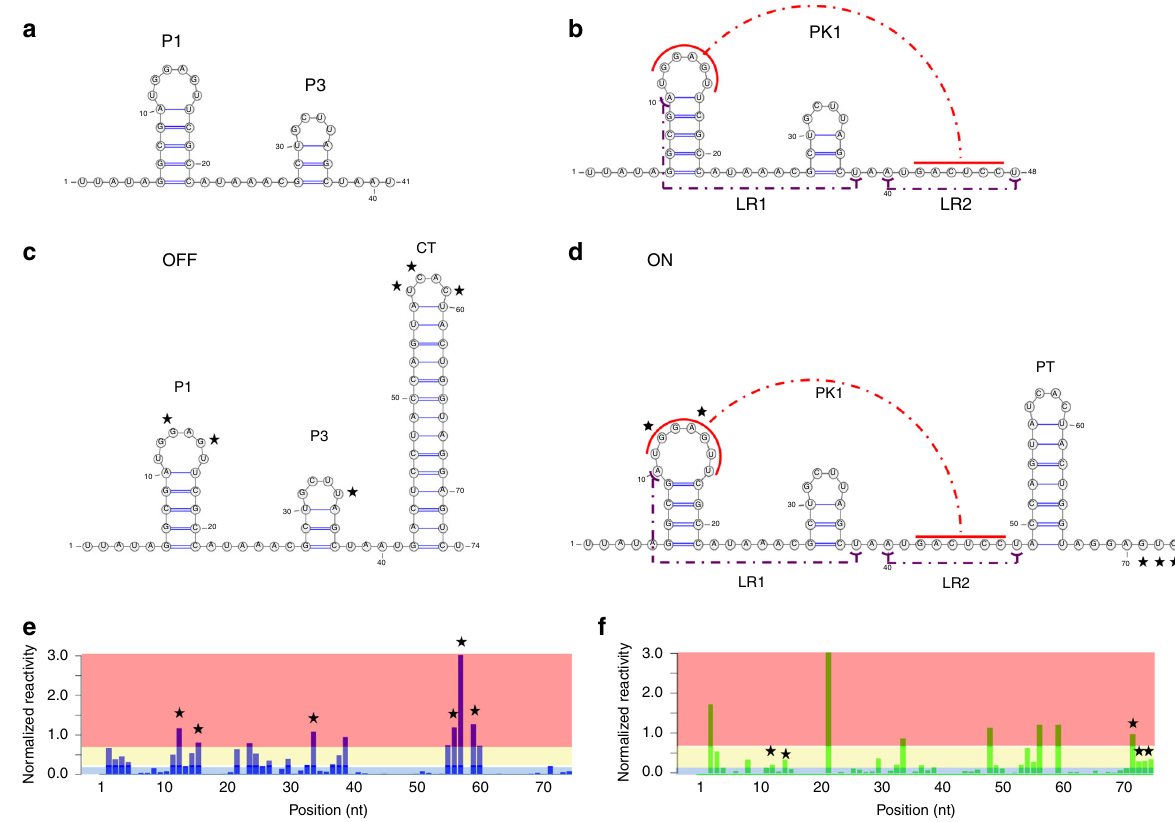
Fig. 3 Structures that govern cotranscriptional folding of crcB fl uoride riboswitch and reactivity pro fi les after formation of a complete terminator (CT). a , b Dominant motifs P1, P3, and PK1 form at intermediate transcript lengths 26, 41, and 49 nt independently of fl uoride presence. c , d At suf fi cient transcript length, fl uoride-dependent structural bifurcation takes place. In the absence of fl uoride, the OFF structure c dominates whereas fl uoride binding results in the emergence of an ON structure d . e , f Reactivity pro fi les matching the transcript length shown in c , d without e and with f fl uoride. Reactivities were normalized by the 2 – 8% strategy 21 . Background colors indicate ranges of high (red)/medium (yellow)/low (blue) reactivities. In the absence of fl uoride, SLEQ ’ s reconstruction indicates that the OFF structure dominates the ensemble. The pro fi le in e reveals strong signals (highlighted by stars) from loops in the P1 and CT hairpins, which agree with the OFF structure. However, the ON structure does not support a P1 loop, as indicated by decreased reactivity in this region (see f ). In the presence of fl uoride, SLEQ reconstructed a heterogeneous ensemble that is well balanced between ON and OFF. The pro fi le in f shows intermediate reactivities at the 3 ′ end, supporting the presence of an ON structure. However, reactivites at the 3 ′ end and at P1 loop regions (highlighted by stars) are in the intermediate range, implying that the average pairing states of nucleotides in these regions are neither fully constrained nor fully unconstrained. This suggests that these data are best supported by a mixture of ON and OFF. Note that despite noticeable differences in ON and OFF structures, regions of pairing-state differences are limited to P1 loop (nucleotides 12 – 16) and the region immediately following PT (nucleotides 67 –